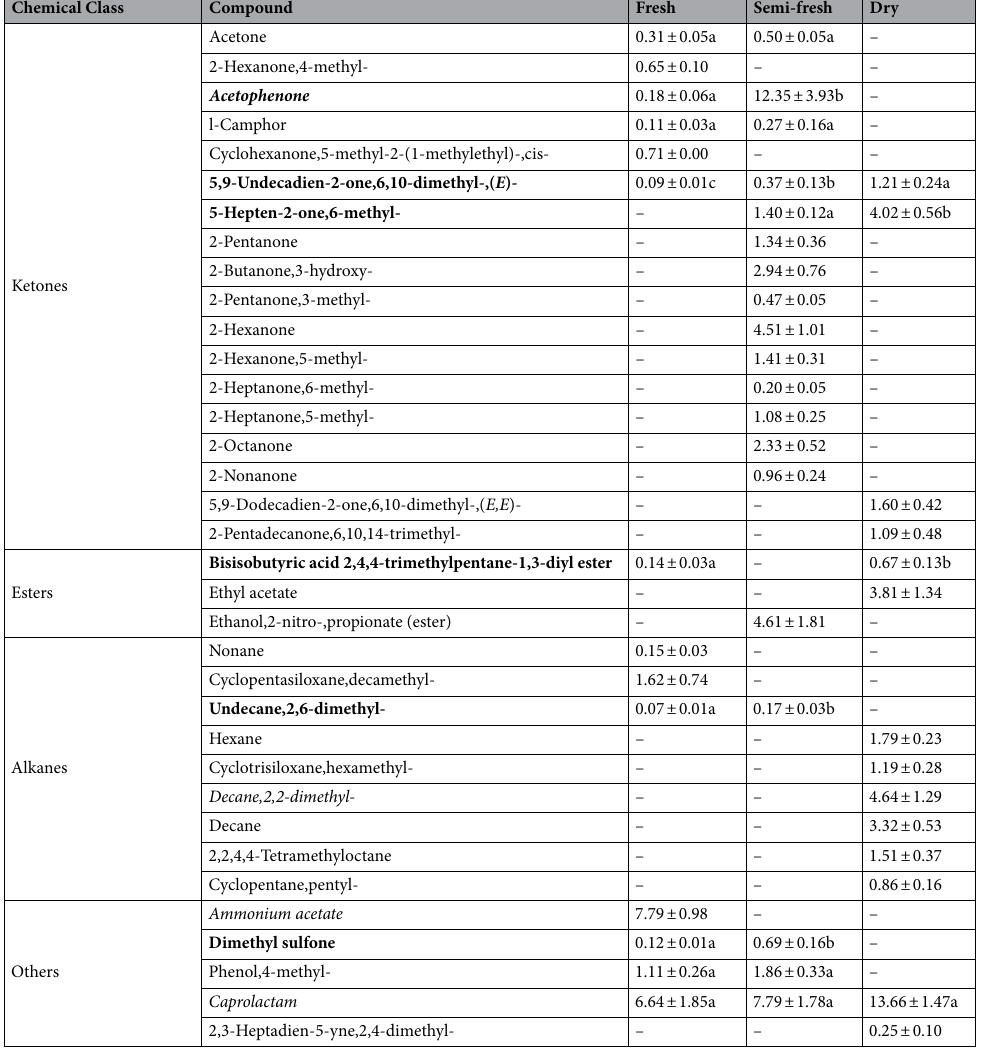
Table 2. The volatiles from feces of Przewalski’s horse with different freshness states at the OVIP stage of Gasterophilus pecorum. Fresh, Semi-fresh, and Dry represent fresh, semi-fresh, and dry feces at the oviposition (OVIP) stage of Gasterophilus pecorum , respectively. The match values of all substances were greater than 700, and those less than 700 were uncertain compounds, which were not listed in this Table 2. *Volatiles written in italic font indicate those of the five most abundant substances between the feces with different freshness. **Data are mean (n = 3) ± SE. Different letters indicate significant differences at P < 0.05. ***Volatiles written in bold font indicate those with significant differences between the feces with different